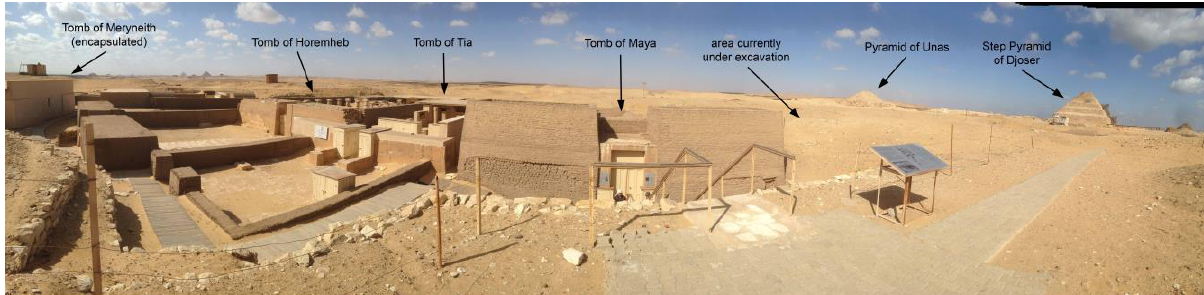
Figure 1. Panoramic view of the area of the New Kingdom tombs of Saqqara, located to the south of the pyramids of Djoser and Unas (photograph by L. Perfetti, 2019).